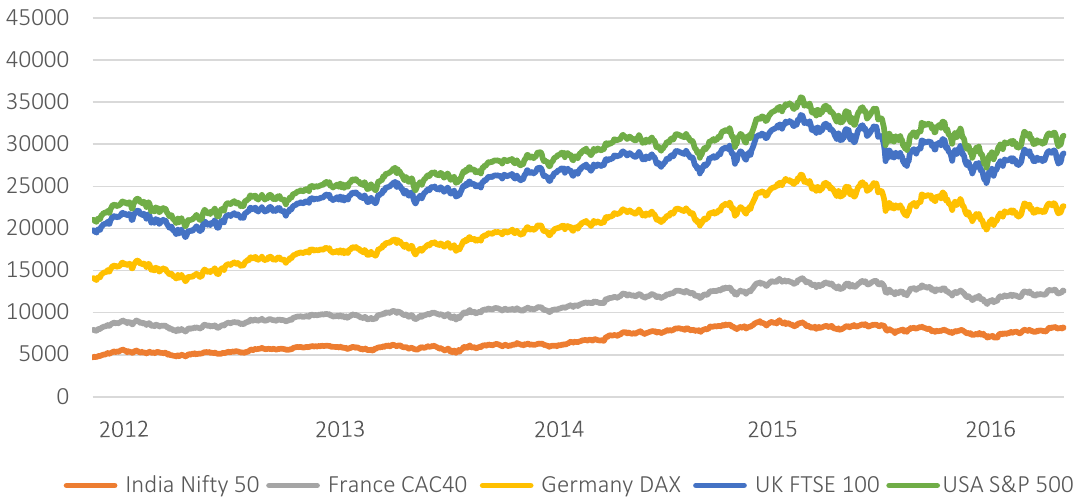
Figure 1. Daily index series for the pre-Brexit referendum